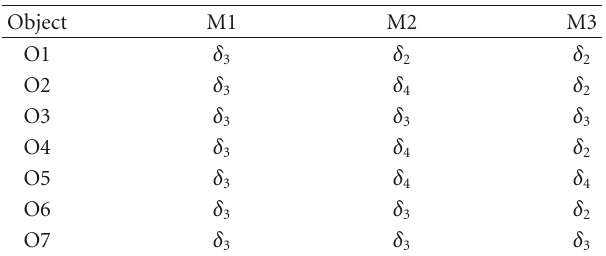
Table 2: The dissimilarity functions used for each combination of object and